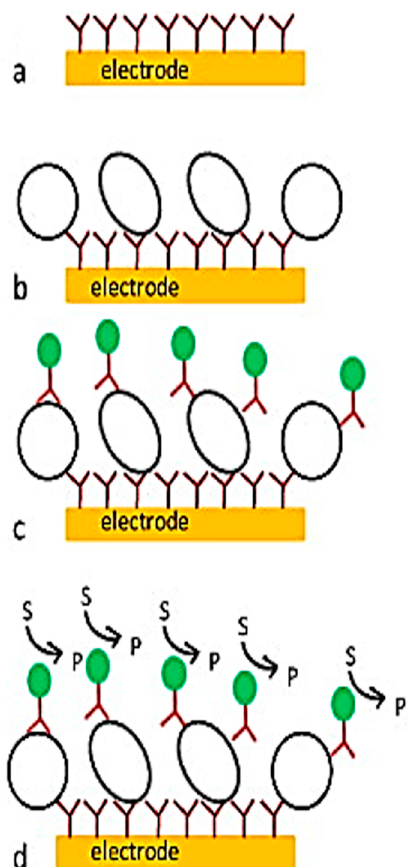
Figure 8. Schematic diagram of an electrochemical biosensor. ( a ) Recognition molecules are immobilized on the electrode surface; ( b ) antigen bonds with the recognition element; and ( c , d ) electrical signal is generated due to the redox reaction in between the binding antigen and the recognition element [89].